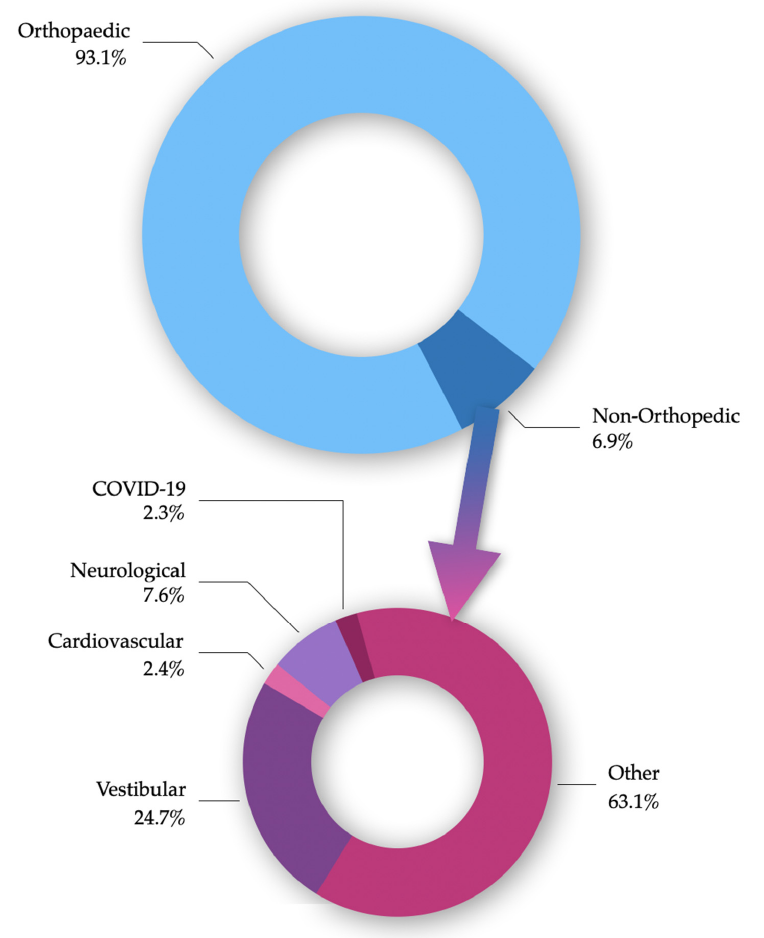
Figure 2. Percentages of the total number of subjects included in the present review with either orthopedic or non-orthopedic complaints. Non-orthopedic complaints were further divided by category (“Other” refers to a group of various pathologies, including: oedema, fibromyalgia, overweight and obesity, spinal disorders, acquired brain injury, pulmonary, oncology and not-better-specified diseases).